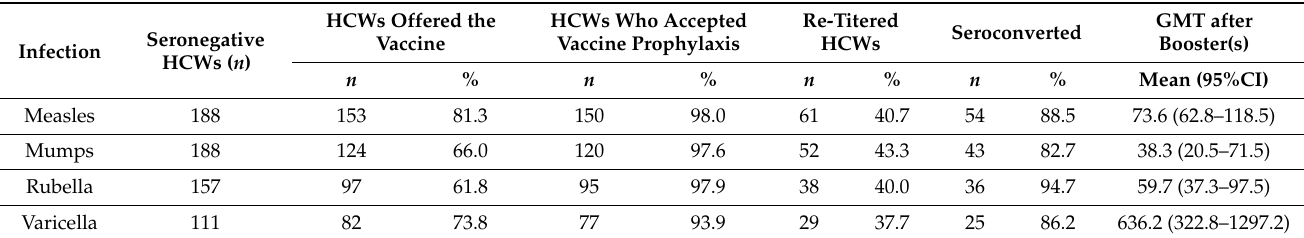
Table 4. Immunization prophylaxis in non-immune HCWs per